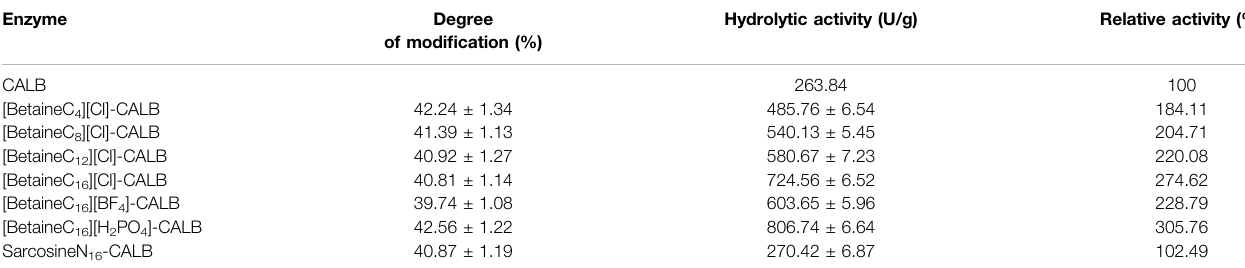
of modi fi cation